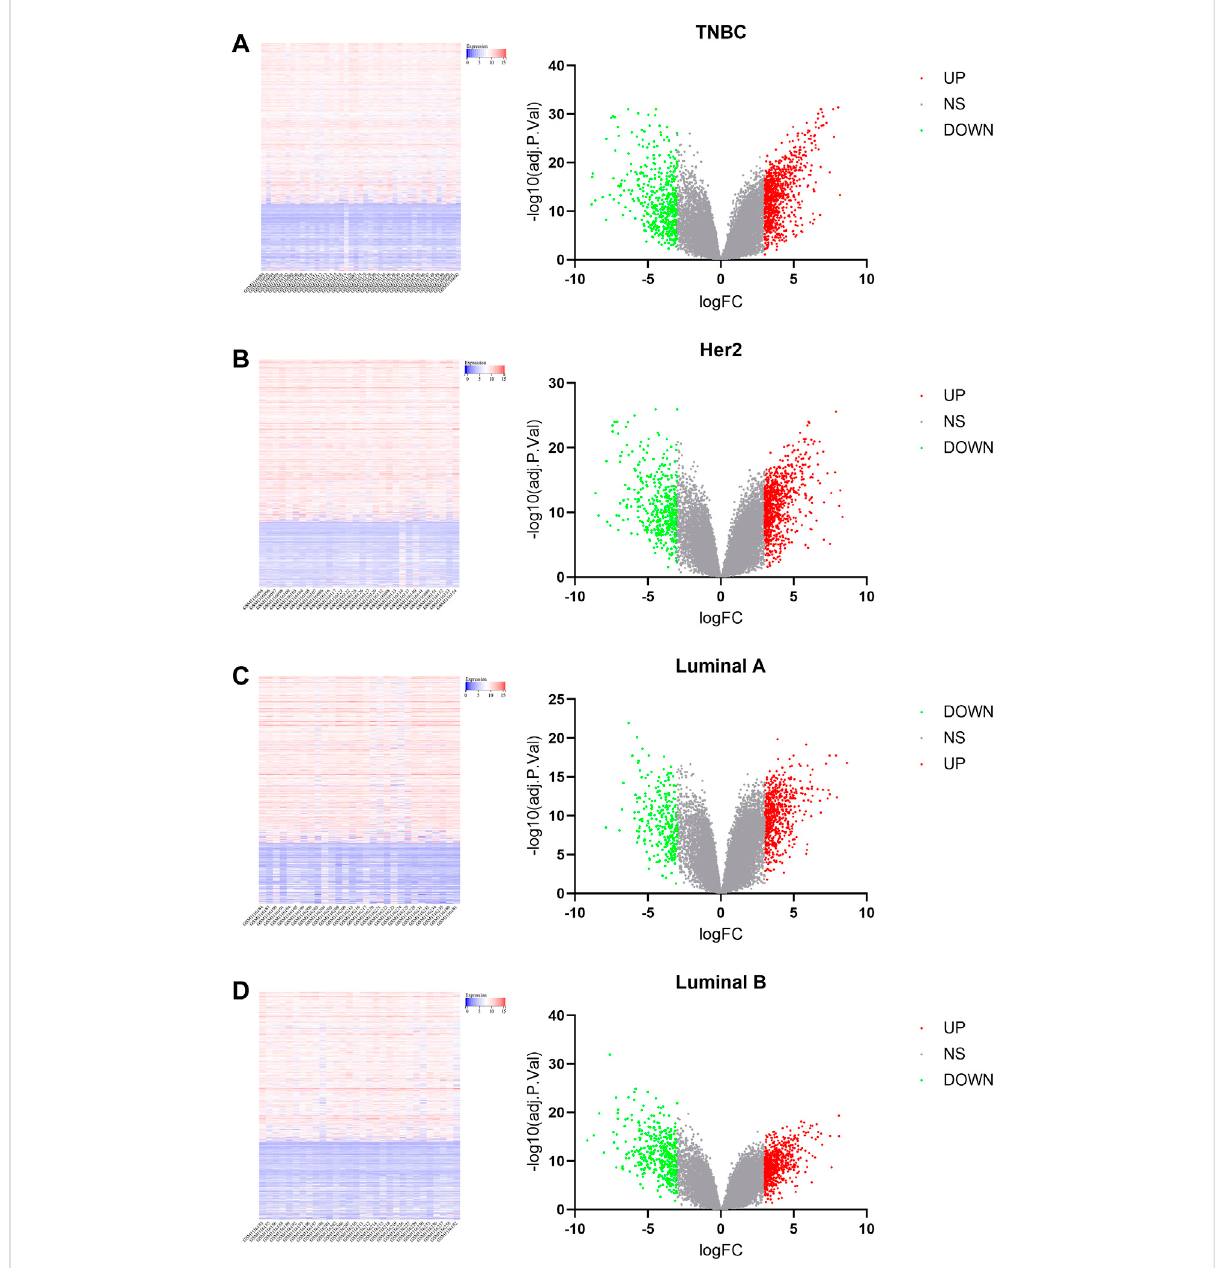
FIGURE 2 HeatmapandvolcanoplotanalysisofDEGs.Inthevolcanoplot,bluedotsontheleftindicatethedownregulatedgenes,graydotsinthemiddle indicate genes that are not differentially expressed, and red dots in the right indicate the upregulated genes. [ (A) : TNBC vs. normal, (B) Her2 vs. normal, (C) luminal A vs. normal, and (D) luminal B vs.